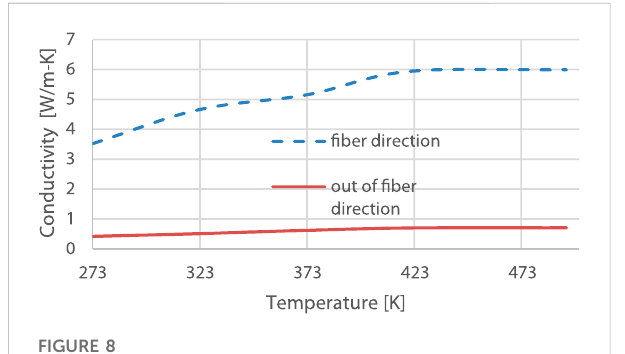
FIGURE 8 Thermal conductivity in fi ber direction and out-of- fi ber direction. These values were taken from (Yousefpour & Hojjati, 2011).